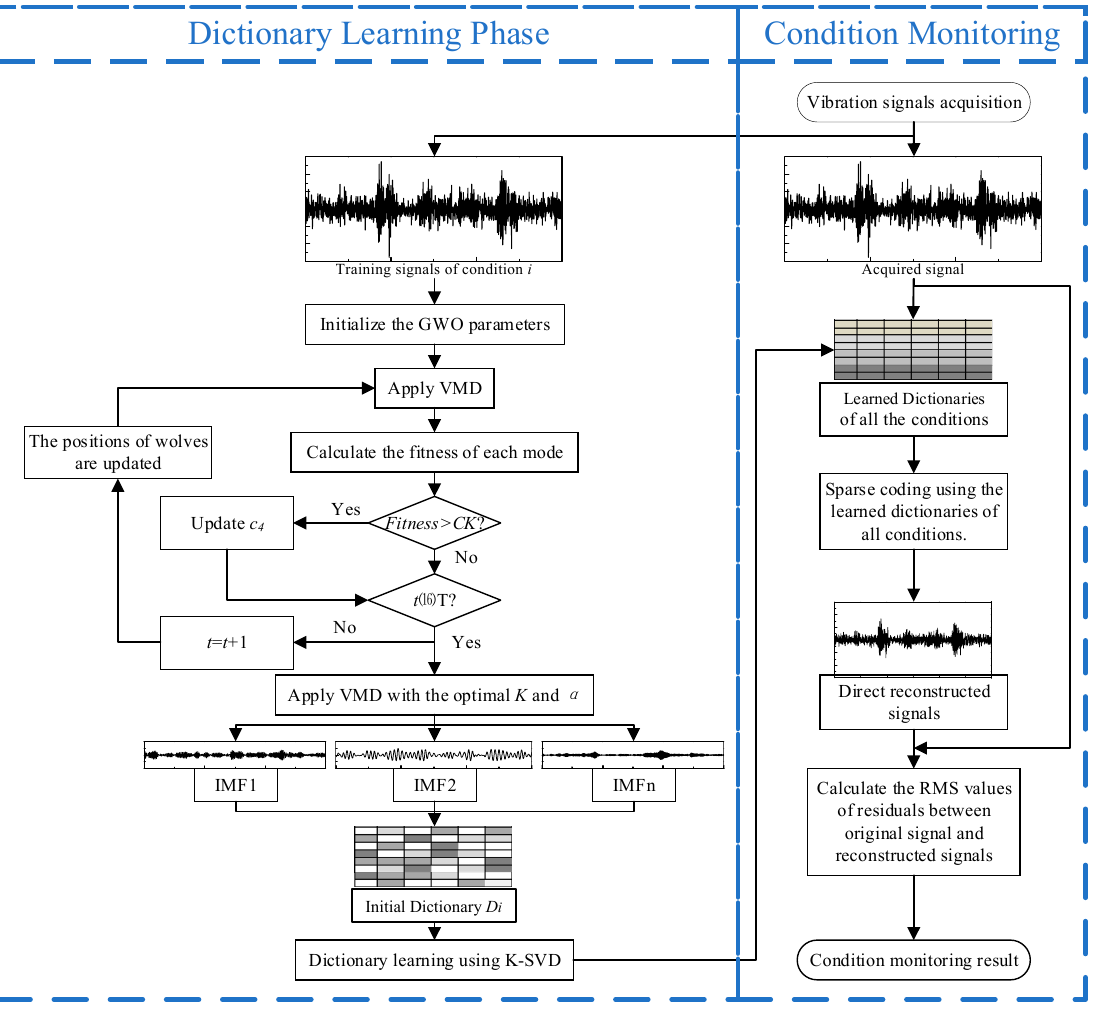
Figure 6. Workflow of condition-monitoring approach.